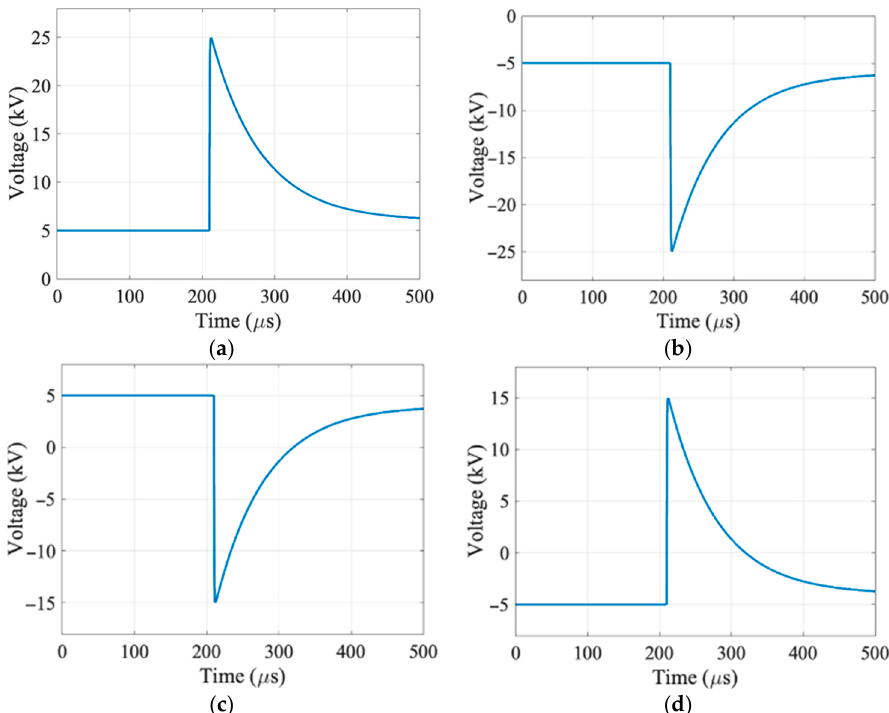
Figure 10. ( a ) Unipolar composite voltage (+DC and +LI); ( b ) unipolar composite voltage ( − DC and − LI); ( c ) bipolar composite voltage (+DC and − LI); ( d ) bipolar composite voltage ( − DC and +LI).